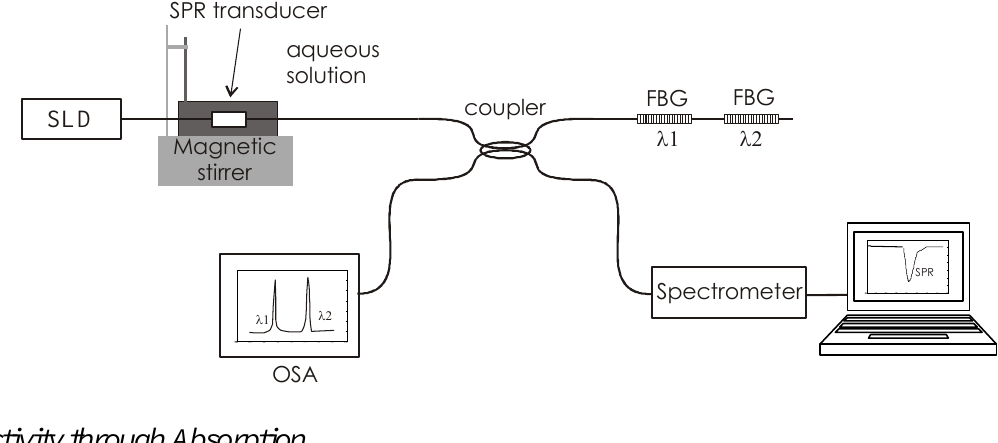
Figure 7. Scheme of an advanced interrogation technique for SPR sensors based on DLUWTs and FBGs (figure originally published in [15], © 2010, reproduced with permission from